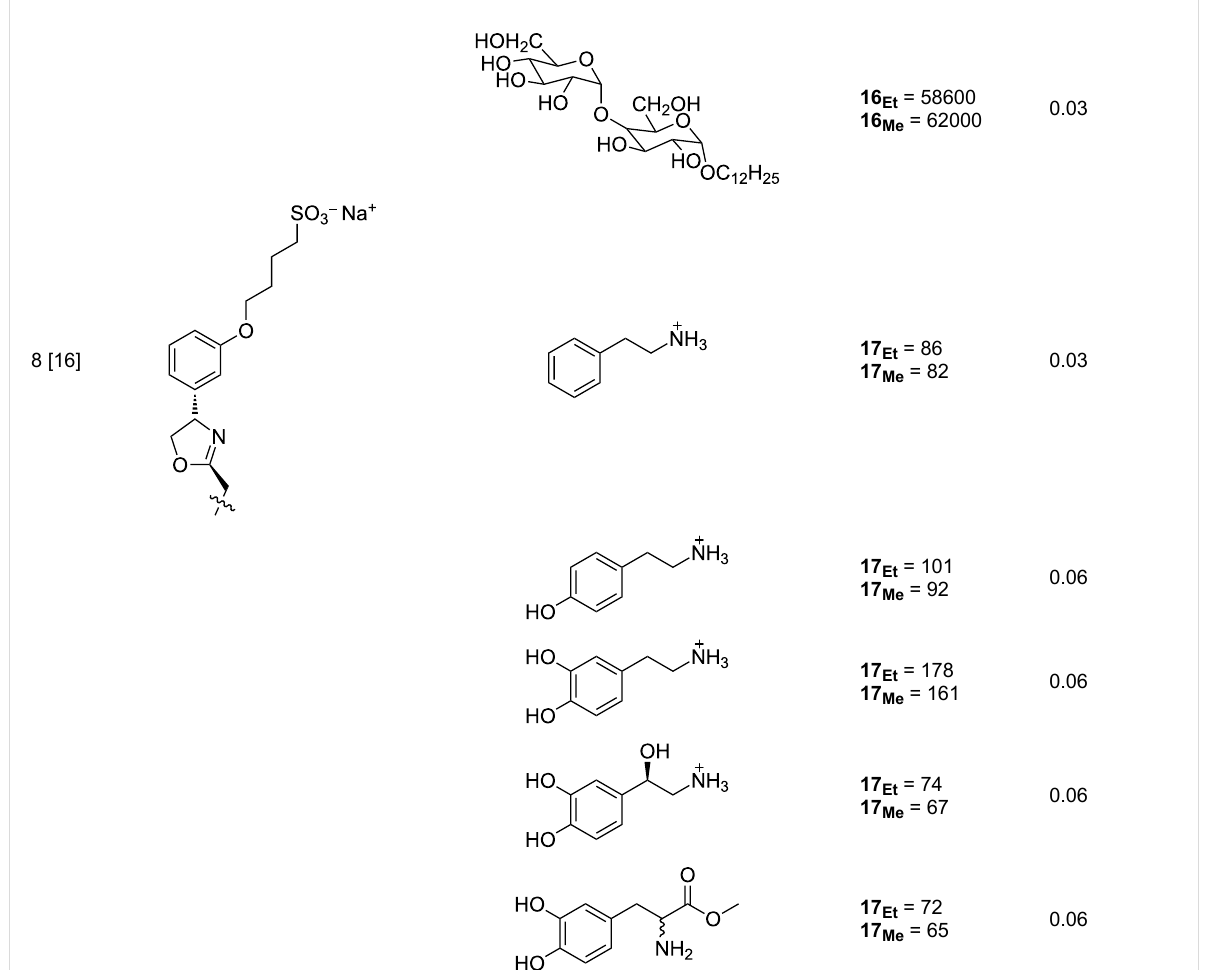
Table 3: Direct affinity comparisons of ethyl- and methyl-substituted hosts. (continued)